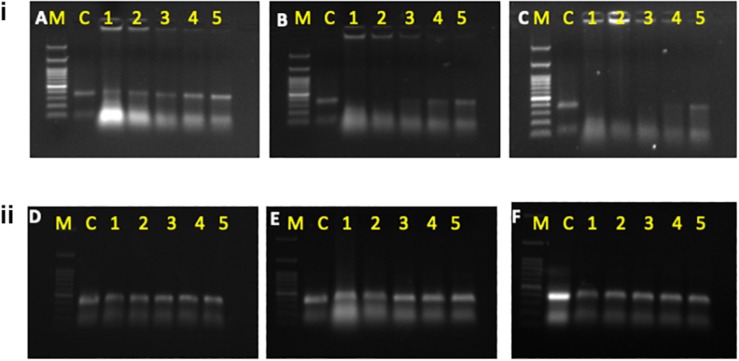
(i) Degradation of dsRNAat different concentrations of hemolymph at different time intervals i.e., 1 h (A), 3 h (B), and 5 h (C). (ii) Degradation of dsRNA at different concentrations of hemolymph isolated from dsRNases knockdown whitefly insects at different time intervals i.e., l h (D), 3 h (E), and 5 h (F) M: 100 bp ladder, C, control dsRNA; 1, crude hemolymph (CH); 2, 1:1 dilution of CH; 3, 1:25 of CH; 4, 1:50 of CH; 5, l:100 of CH.